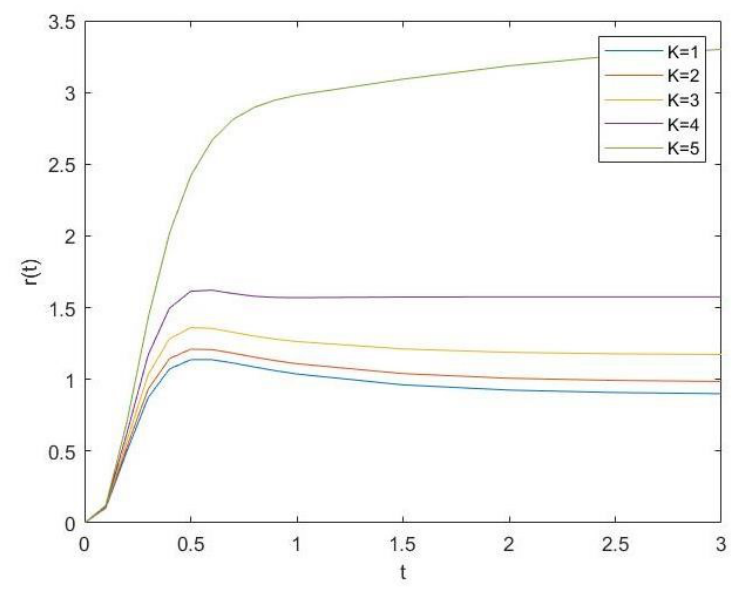
Figure 3. Rate of system failure function for systems K =